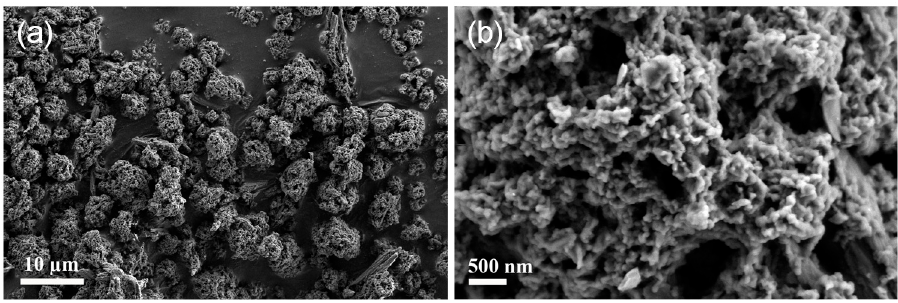
Figure 3. SEM images of the untreated wool powders at: ( a ) low and ( b ) high magnifications.